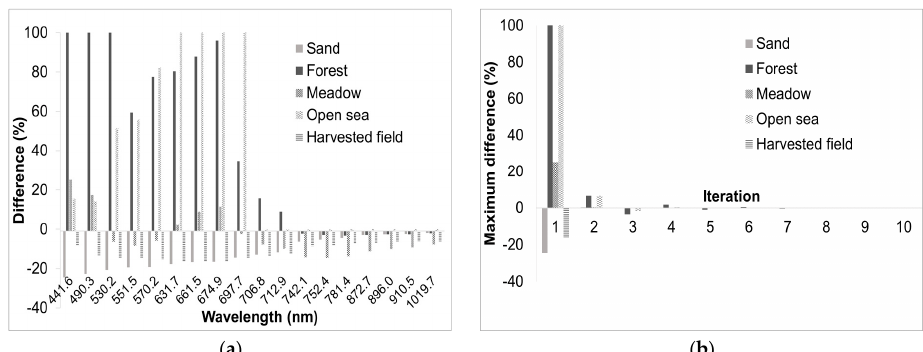
Figure 11. Spectral dependence of the difference between the retrieved reflectance at first iteration and the asymptotic value reached at iteration n = 10 ( a ). Maximum value for the difference between the retrieved reflectance at iteration n and asymptotic value reached at iteration n = 10 ( b ). The difference was evaluated for different coverages.